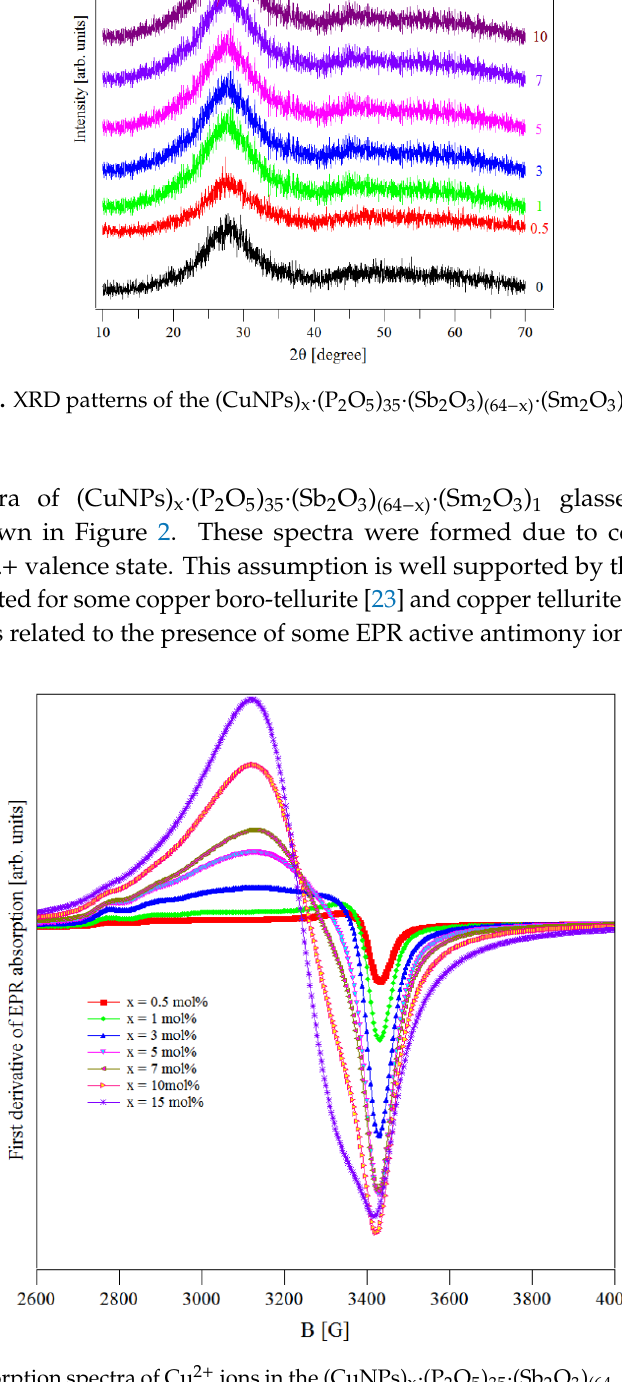
Figure 2. EPR absorption spectra of Cu 2 + ions in the (CuNPs) x · (P 2 O 5 ) 35 · (Sb 2 O 3 ) (64 − x) · (Sm 2 O 3 ) 1 glasses .